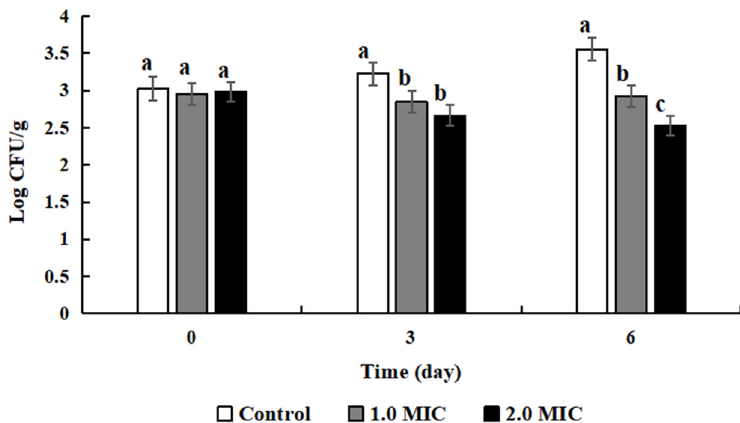
Figure 7. Antibacterial effect of ATCE on S. aureus ATCC 13565 inoculated into sterile lean cooked pork during storage. Values denote the means of triplicate measurements. Error bars represent standard deviation ( n = 3). Different letters represent significant differences ( p <